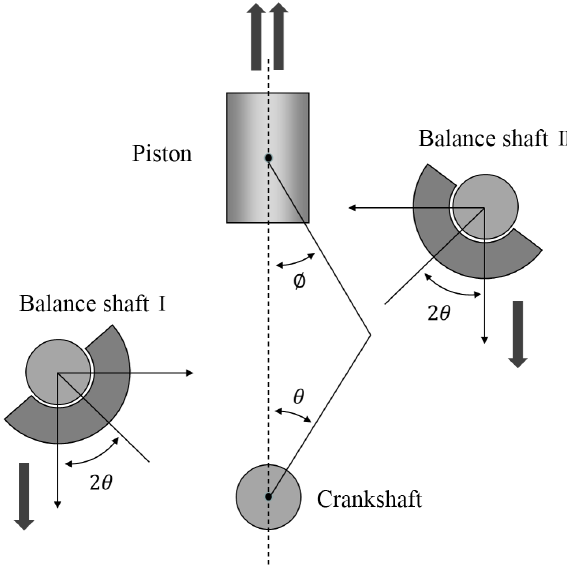
Figure 1. Simplified engine module kinematics.